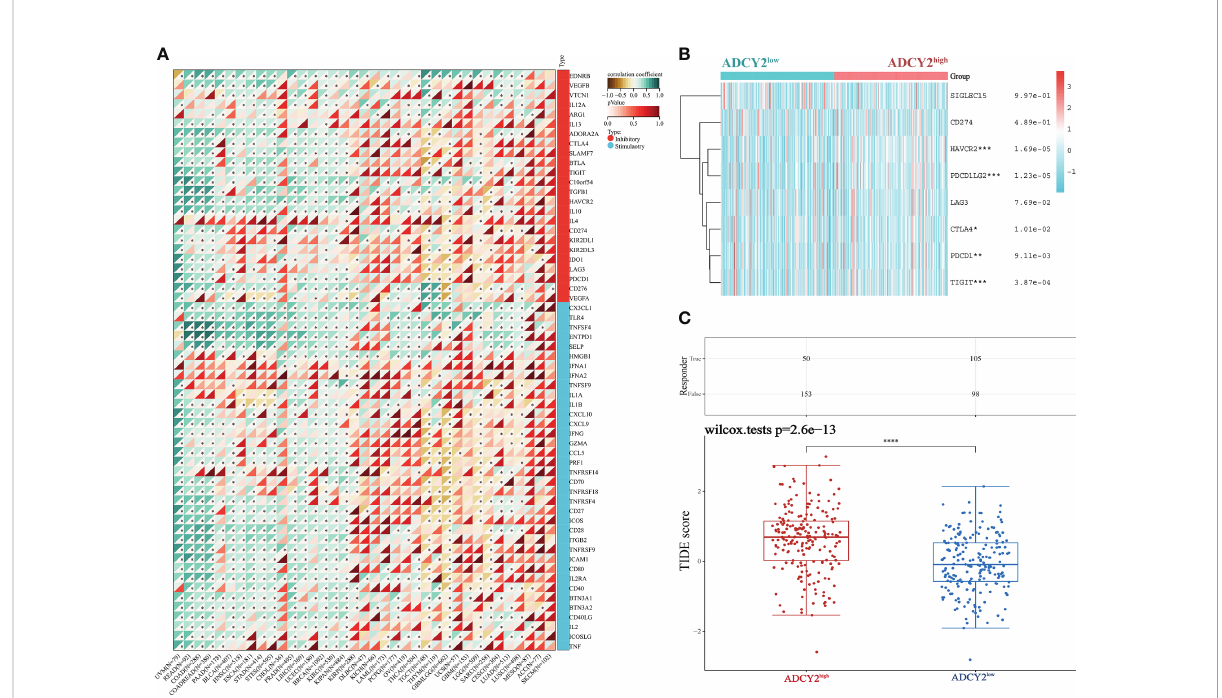
FIGURE 7 Relationship between ADCY2 expression and immune checkpoints in cancers and its implications in immunogenicity and tumor heterogeneity of BCa. (A) Molecular correlation analysis of ADCY2 and immune checkpoint in pan-cancer. (B) Heat map association between ADCY2 high and low groups and critical immune checkpoints in BCa. (C) TIDE scores in two groups of BCa samples. *p<0.05; **p<0.01; ***p<0.001;